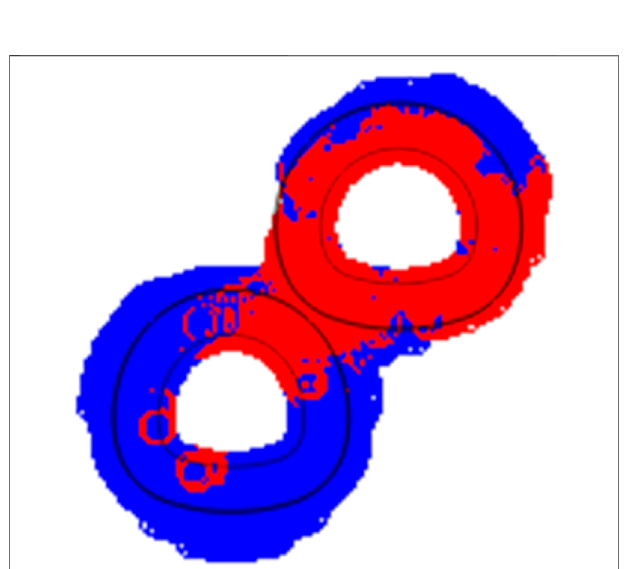
FIGURE10| Distributionoftheplasticzoneafterexcavationoftheupper tunnel (red: plastic or failure; blue: unloading or reloading).